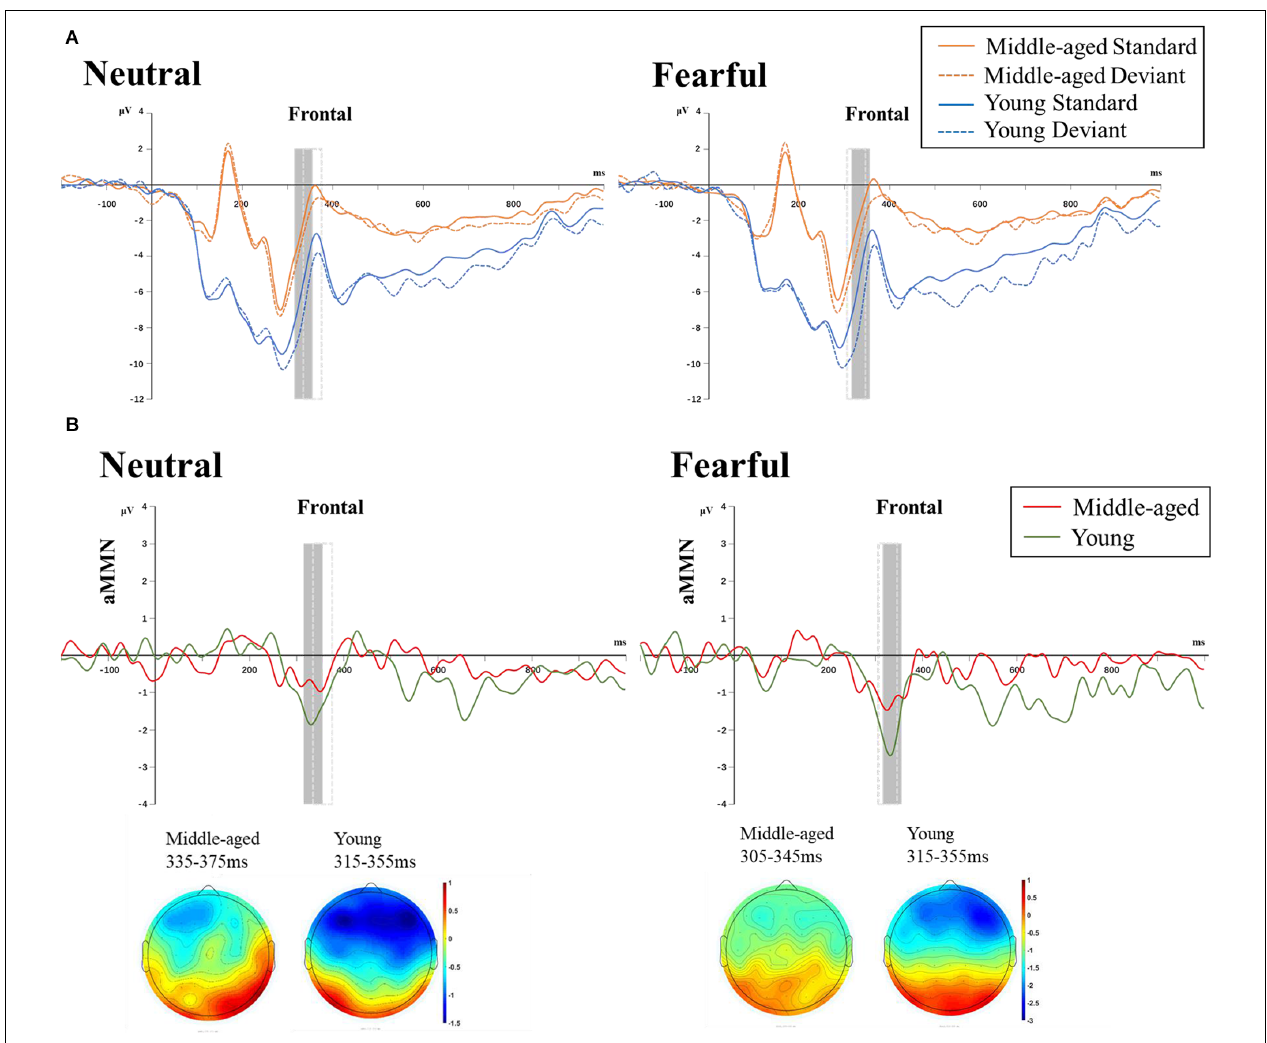
FIGURE 4 | (A) ERPs induced by auditory standard and deviant stimuli under neutral (left) and fearful (right) facial expressions in the two age groups at frontal channels (averaged across F3, Fz, F4). (B) Difference wave (neutral MMN = neutral deviant − neutral standard; fearful MMN = fearful deviant − fearful standard) and topographic maps of the two age group under neutral (left) and fearful (right) expressions. The gray box indicated the time window for young adults and the dotted box for middle-aged adults. The main effect of Emotion and Age were significant. Note: All ERP waveforms were filtered by a 25 Hz low-pass filter only for graphical